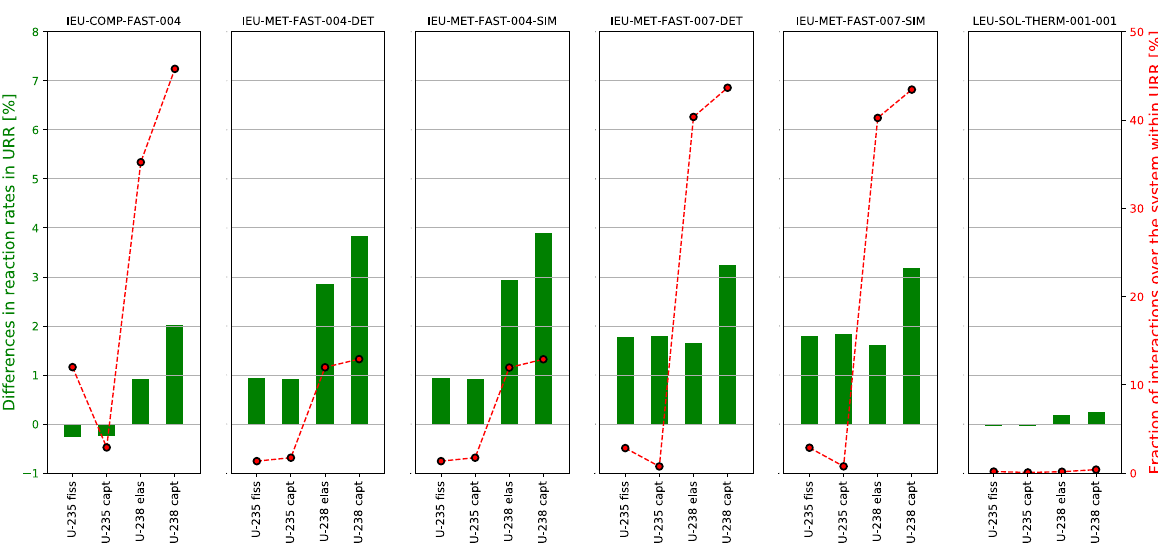
Figure 3. Differences in reaction rates in the URR with and without PT and fraction of interactions within the URR for IEU and LEU benchmarks. Relative values computed as (rr noPT – rr PT )/rr PT Results for the mixed uranium-plutonium and plutonium benchmarks are in Figure 4. Both MIX benchmarks are useful to analyse the PT treatment of U-238 and Pu-239, since there are differences in their reaction rates and a significant fraction of those reactions are within the corresponding URR. The most sensitive Pu benchmark is PU-COMP-INTER-001, although MET-FAST benchmarks exhibit also a non- negligible fraction of Pu-239 captures in the URR together with relevant differences in reaction rates. In the Pu benchmarks with thermal spectrum, the fraction of interactions in the URR is insignificant.